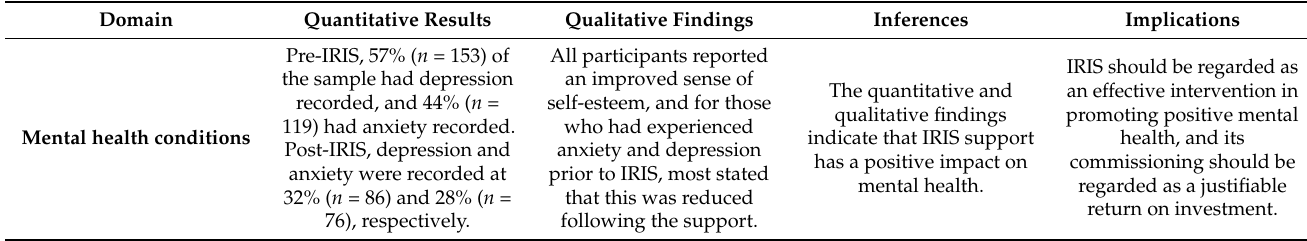
Table 2. Mixed-methods data-integration